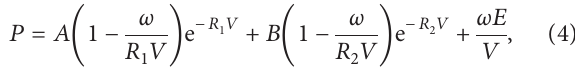
Figure 13. Shear failure and tensile failure occurred in